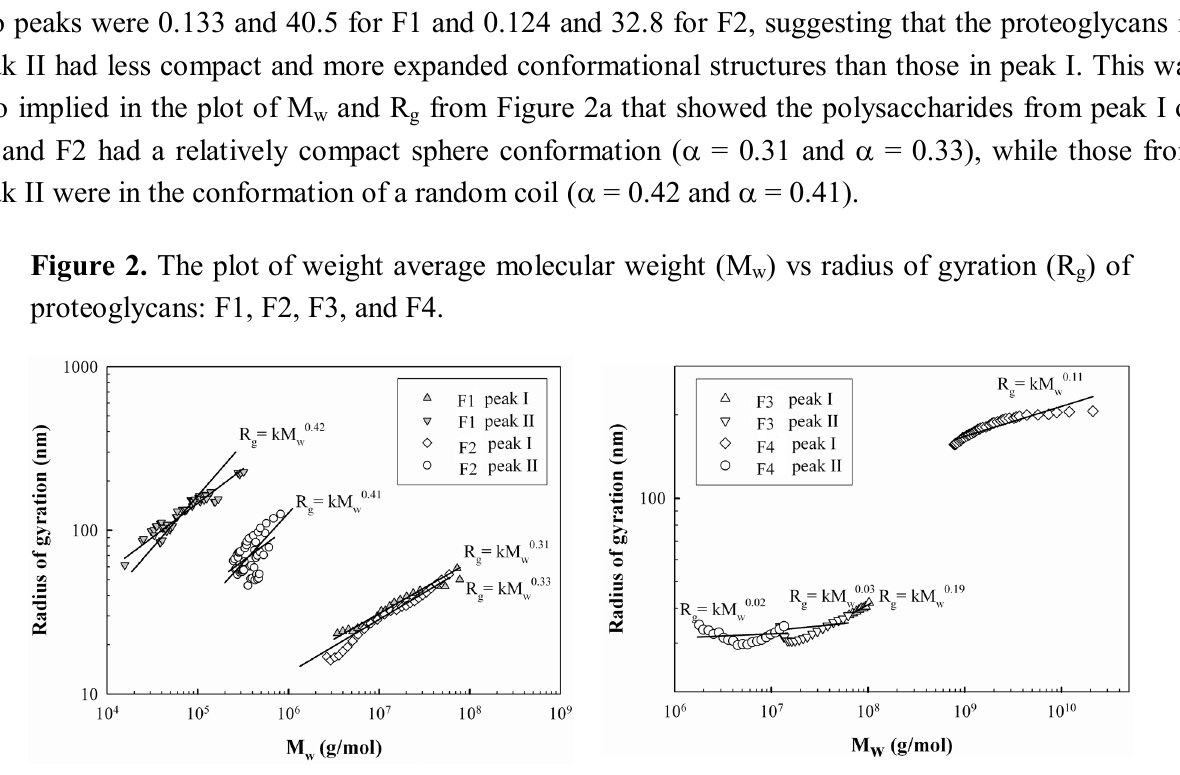
) vs radius of gyration (R w